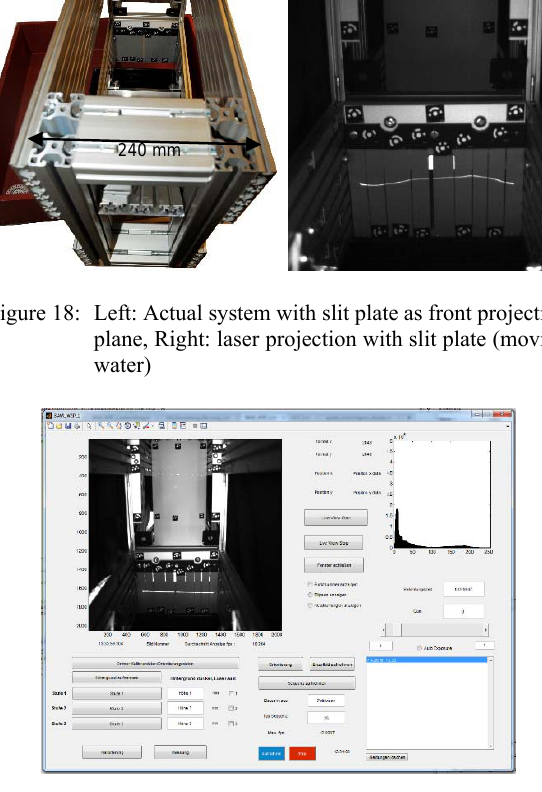
Figure 19: Graphical user